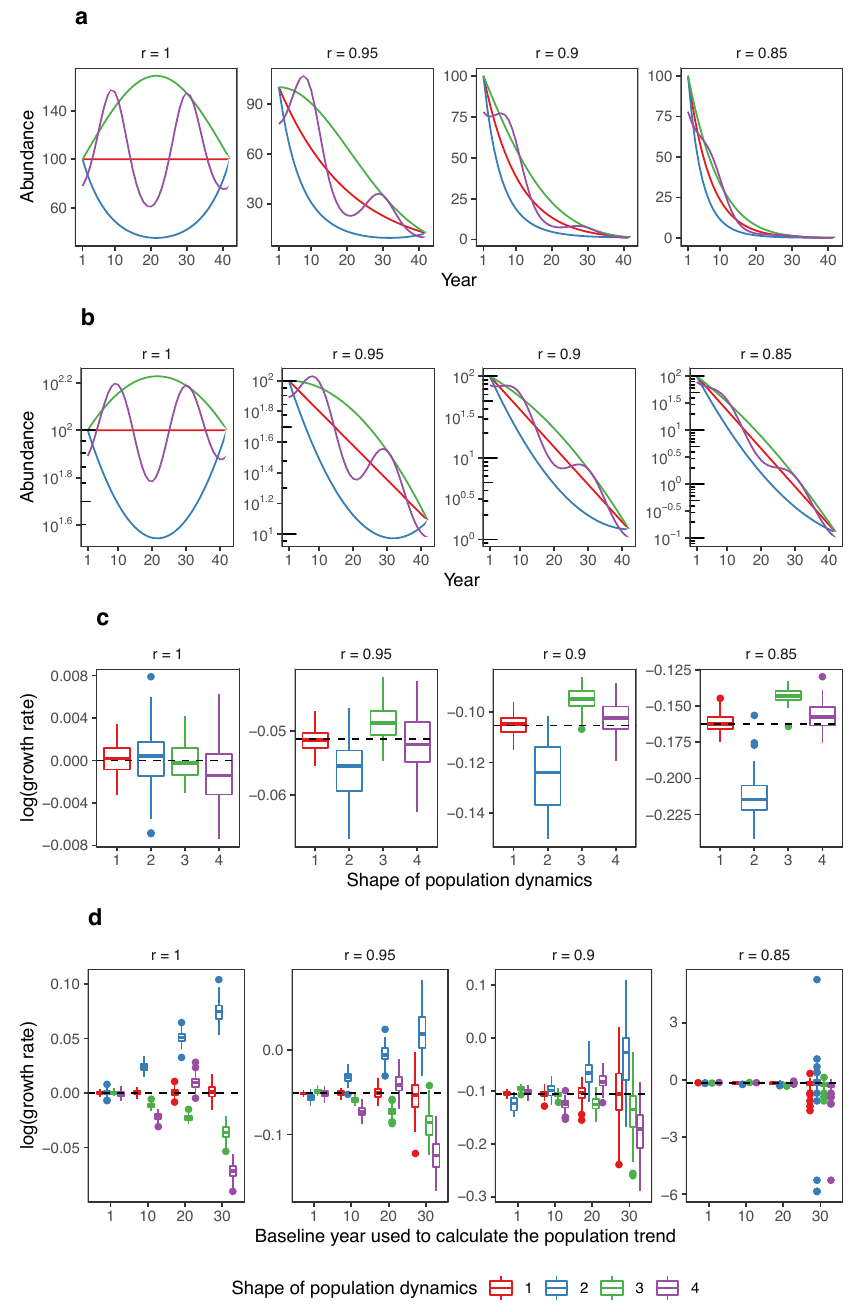
Figure 4: Non-linear population dynamics can bias estimated abundance trends. (a) Raw patterns of population dynamics when the population is stable, i.e. with a growth rate r = 1, or when the population declines by 5% ( r =0.95), 10% ( r =0.9) or 15% ( r =0.85) each year. (b) Scaled patterns of population dynamics shown in (a) but using a log10 y-axis scale illustrating that the red curve corresponds to linear dynamics (cf. Supplementary methods, Fig. S2). (c) Estimated values of log( r ) as a function of the shape of the population dynamics over 100 stochastic simulations per type of population dynamics. (d) Estimated values of log( r ) as a function of the shape of the population dynamics and of the baseline year used to truncate the time series. In (c) and (d) the dashed horizontal line shows the value of the logarithm of the true (simulated) growth rate. Boxplots have the same meaning as in Figure 3. The right panel of (d) without outliers is represented in Figure